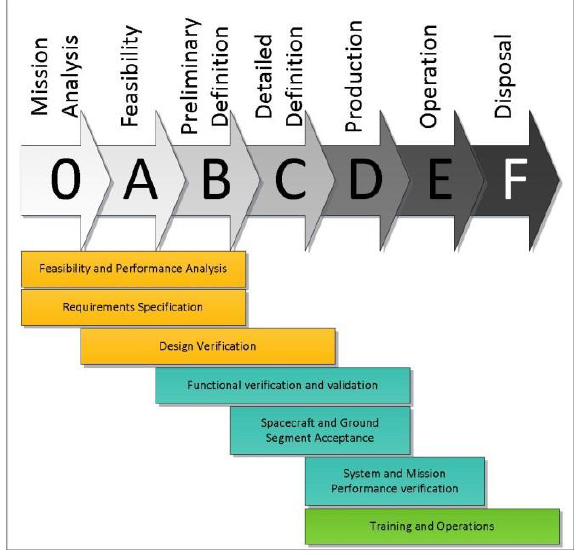
Fig. 8. Simulators are used throughout the Space System Lifecycle